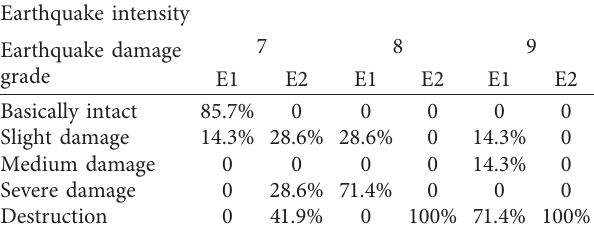
Table 11: Seismic damage prediction matrix of bridge bearing.